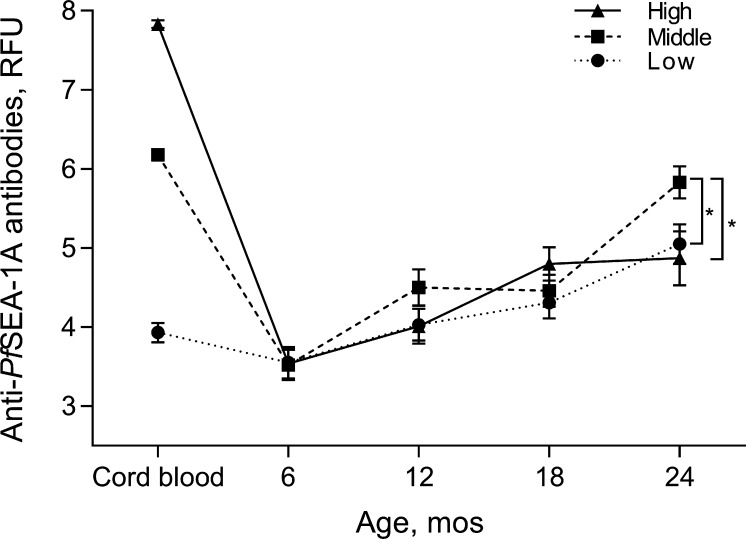
Effects of maternally-derived anti-PfSEA-1A antibodies in cord blood on endogenous anti-PfSEA-1A antibodies measured in infants. Infants were grouped by tertiles of anti-PfSEA-1A antibodies in cord blood. Anti-PfSEA-1A antibody levels were natural log-transformed. Error bars represent 95% confidence intervals. *P < 0.01.